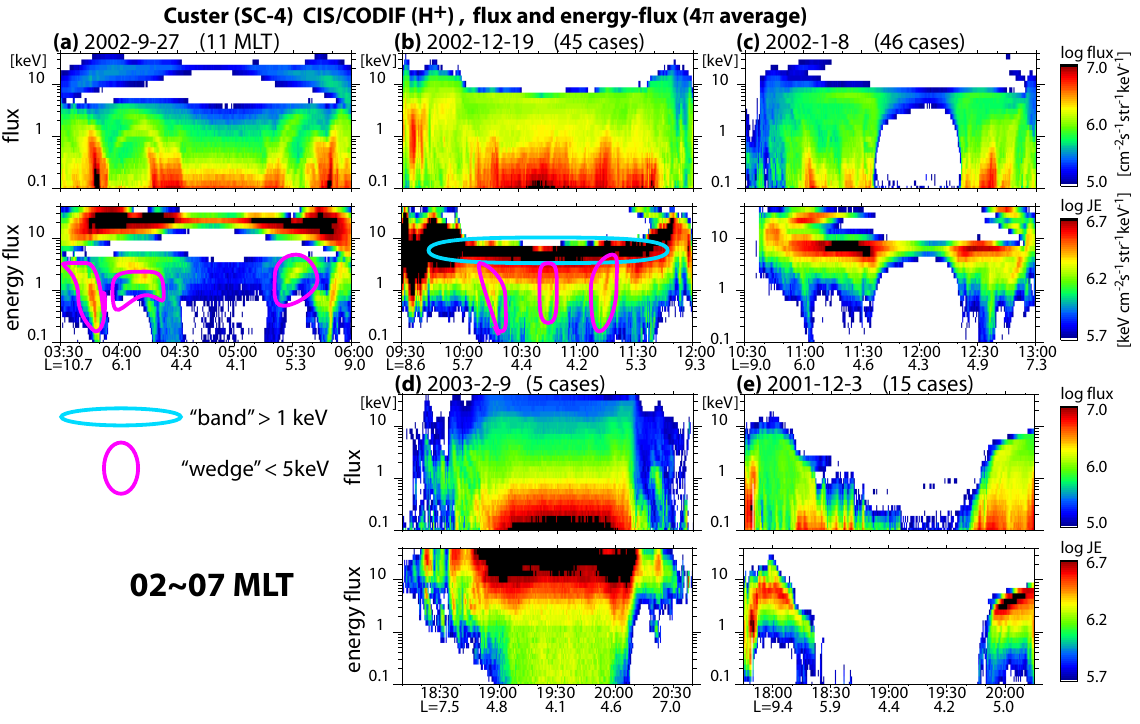
Fig. 1. Energy-time spectrograms of 4 π averaged proton flux (upper) and energy flux (lower) observed by Cluster spacecraft-4 CIS/CODIF at 0.1–40keV. Five traversals (150min each) are displayed from (a) 11LT and (b) ∼ (e) 02 ∼ 07LT. The spacecraft location is given by L value. The uniform background count that peaks near the middle part (04:30 ∼ 05:20UT in (a), 10:20 ∼ 11:20UT in (b), and 19:00 ∼ 20:00 UT in (d)) is contamination from MeV particles of the radiation belt (they penetrate through the walls of the instrument). Since this contamination is independent of measurement energy, it appears uniform in the energy flux and counter proportional to the energy in the flux. The band-like structure is marked by blue line and the wedge-like energy-latitude sub-keV ion structure is marked by purple